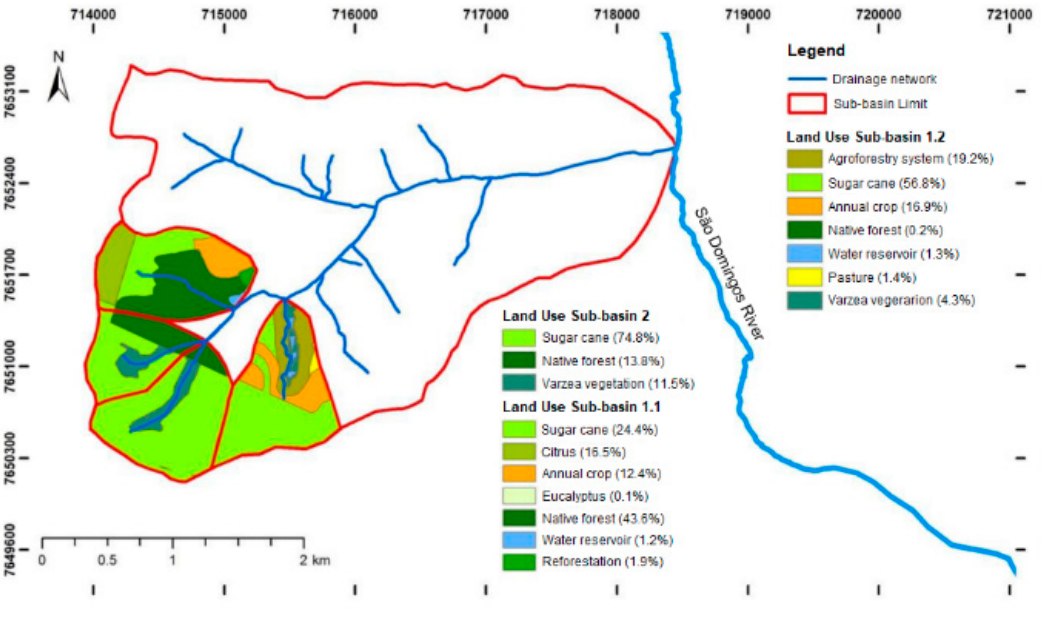
Figure 9. Land use land cover (LULC) at Olaria stream sub-basins, State of São Paulo,